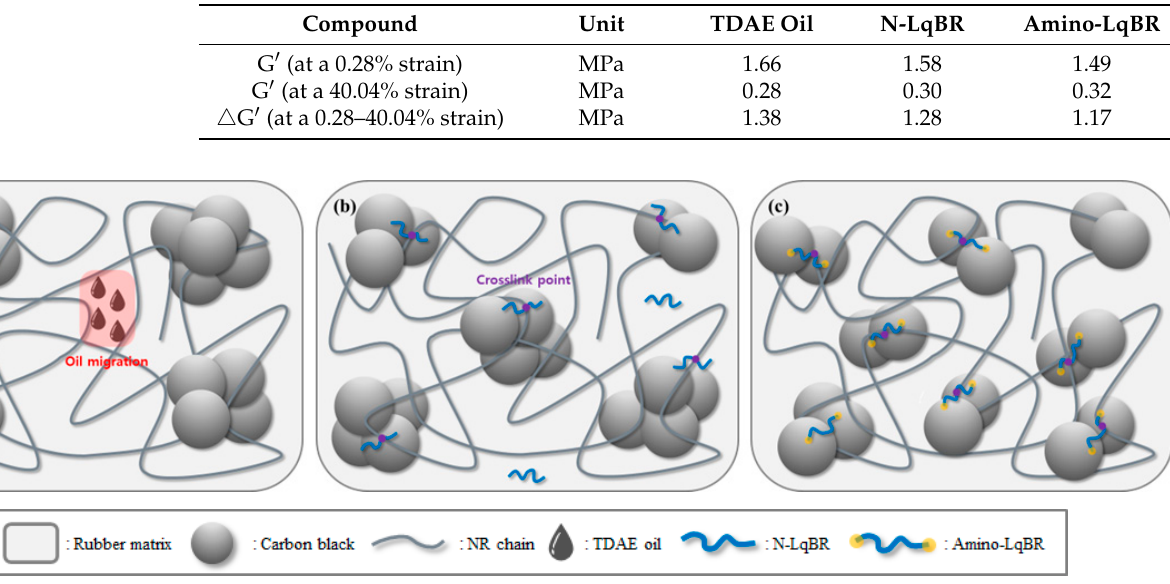
Table 6. Cure characteristics and Mooney viscosity of the compounds.